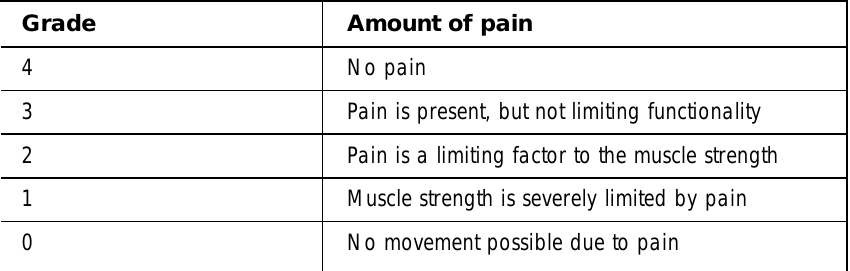
Table 3: Grading of manual muscle tests according to pain adapted from Itoi et al. (1999)